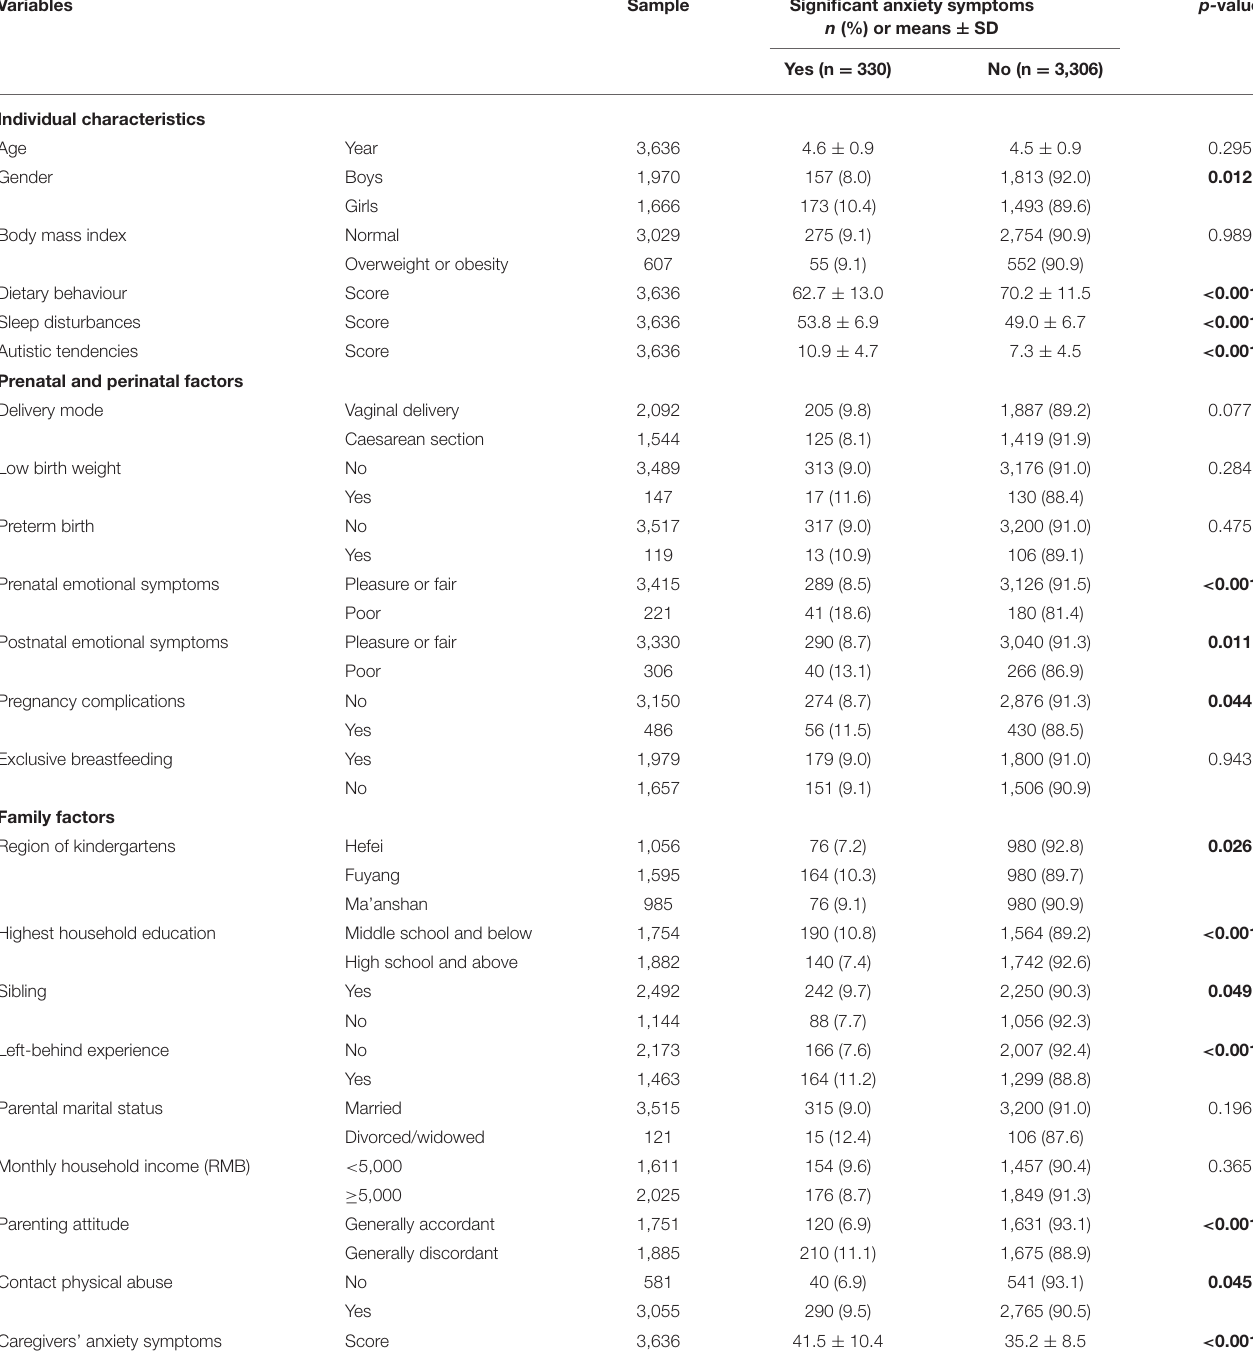
TABLE 1 | Individual, prenatal and perinatal, and family factors by preschool children’s anxiety symptoms.